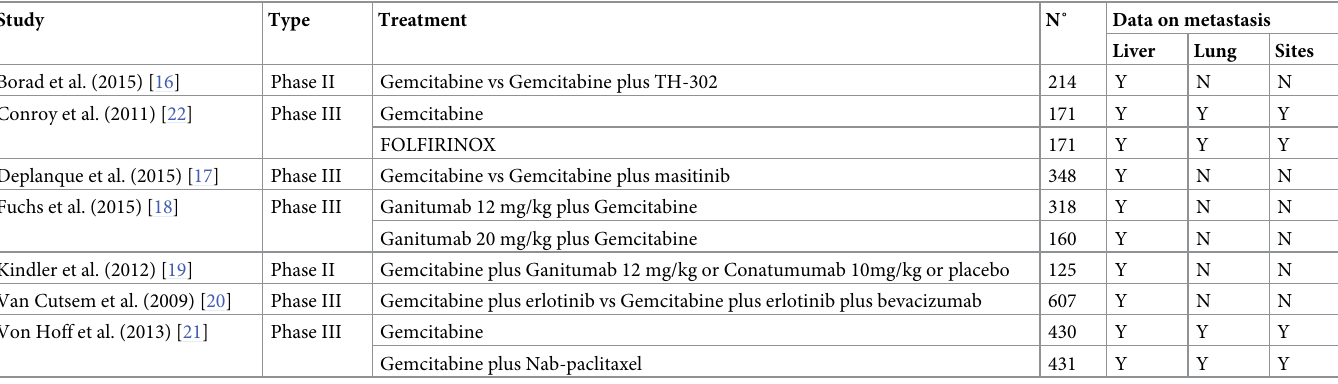
Table 1. Summary of included